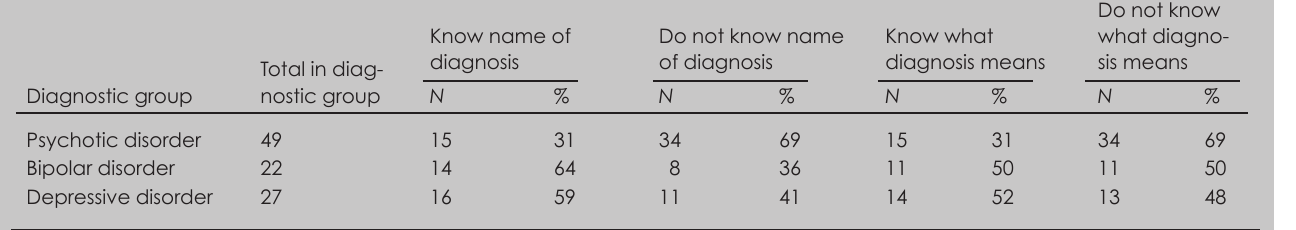
Table II. Diagnostic group and knowledge of diagnosis